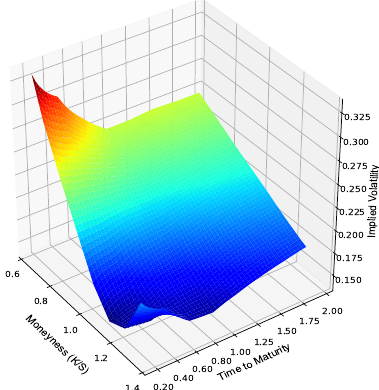
Figure 2. Implied volatility surface.